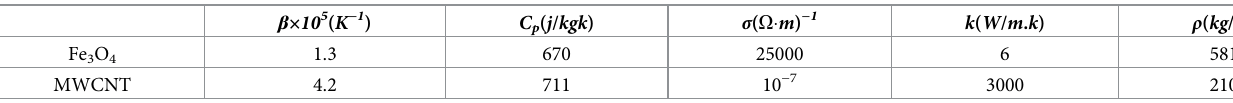
Table 2. Characteristics of hybrid (MWCNT and Fe 3 O 4 ) nanomaterials [42]. β × 10 5 ( K − 1